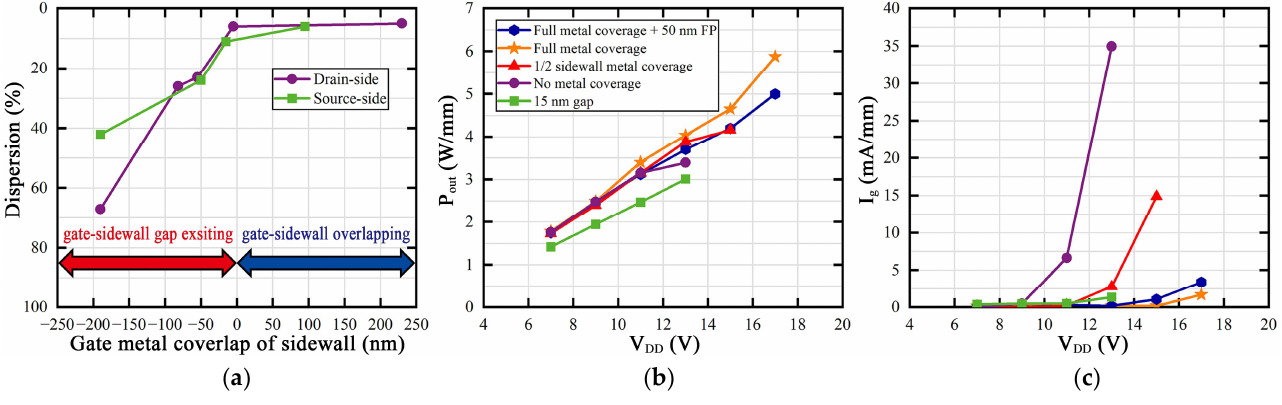
Figure 13. ( a ) Plots of the dispersion vs. source-side and drain-side gap. ( b,c ) The performance of output power and gate leakage current at different gate coverage. Reworked from Ref. [59].